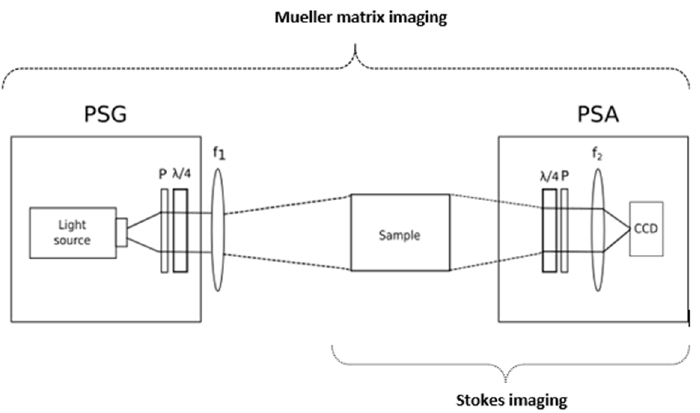
Figure 7. Stokes and Mueller matrix imaging (MMI) setup. The Stokes imaging setup included the sample and the polarization state analyzer (PSA). The PSA is a quarter wave plate (QWP) followed by a polarizer (P) and the optical relays (f 2 ) to focus the light onto the sensor. The MMI setup consists in the previous setup with a polarization state generator (PSG). The PSG comprises a light source, a polarizer (P), and a QWP. The optical set (f1) focuses the input light on the sam- ple.